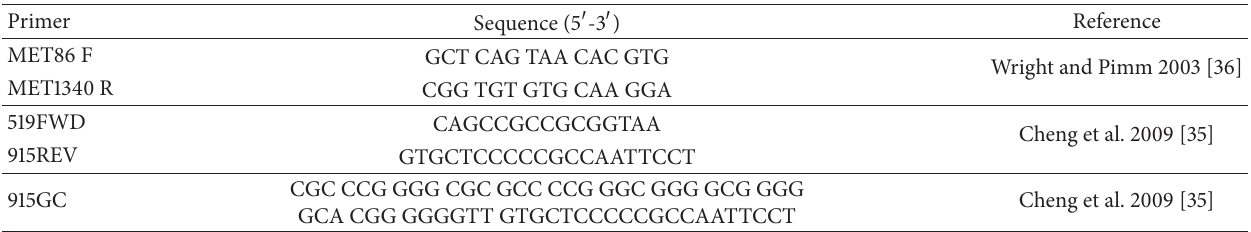
Table 3: List of primers for PCR amplification of 16S rDNA gene and DGGE used in the present study. Primer